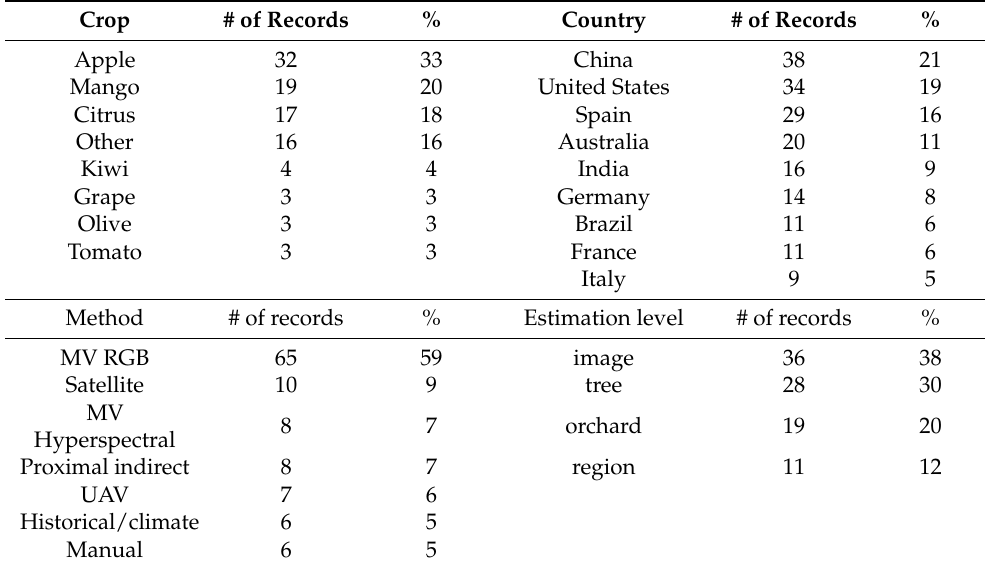
Table 1. Literature base as indexed by Scopus records (doa 8/2/2021) for the keywords ‘fruit AND yield AND estimation’ for the years 2010–2021. # represents